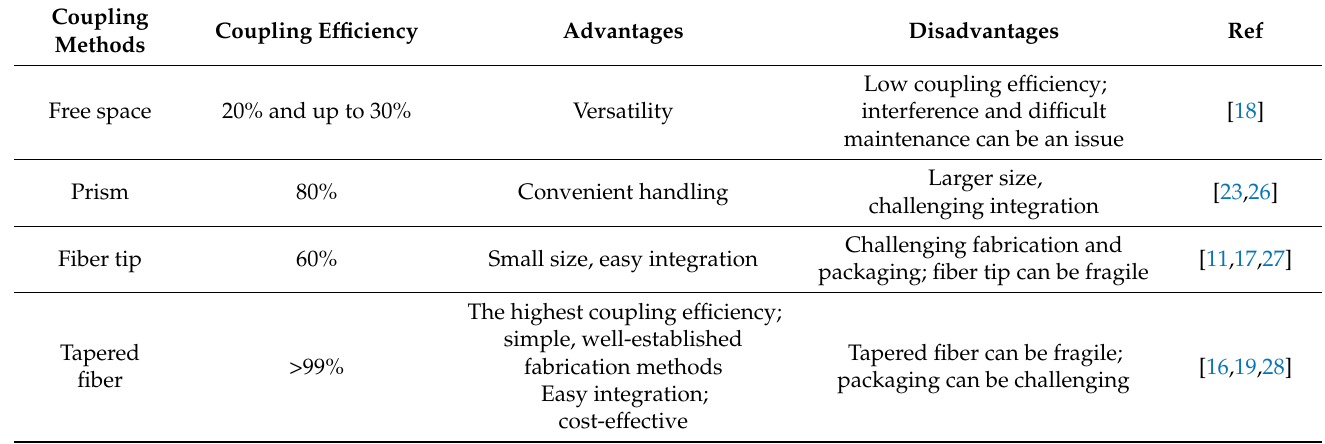
Table 1. MBR coupling method